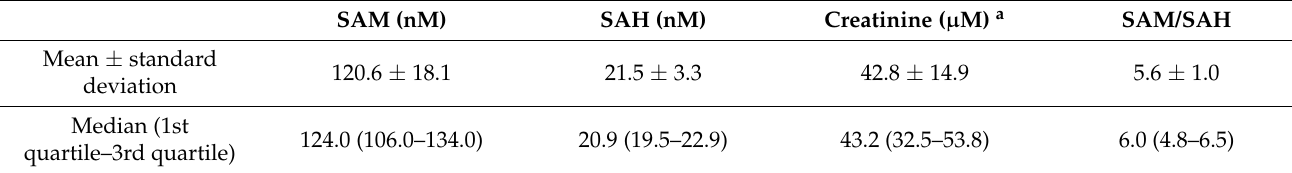
Table 2. Concentration of plasma SAM, SAH, and creatinine in healthy adults ( n = 33).